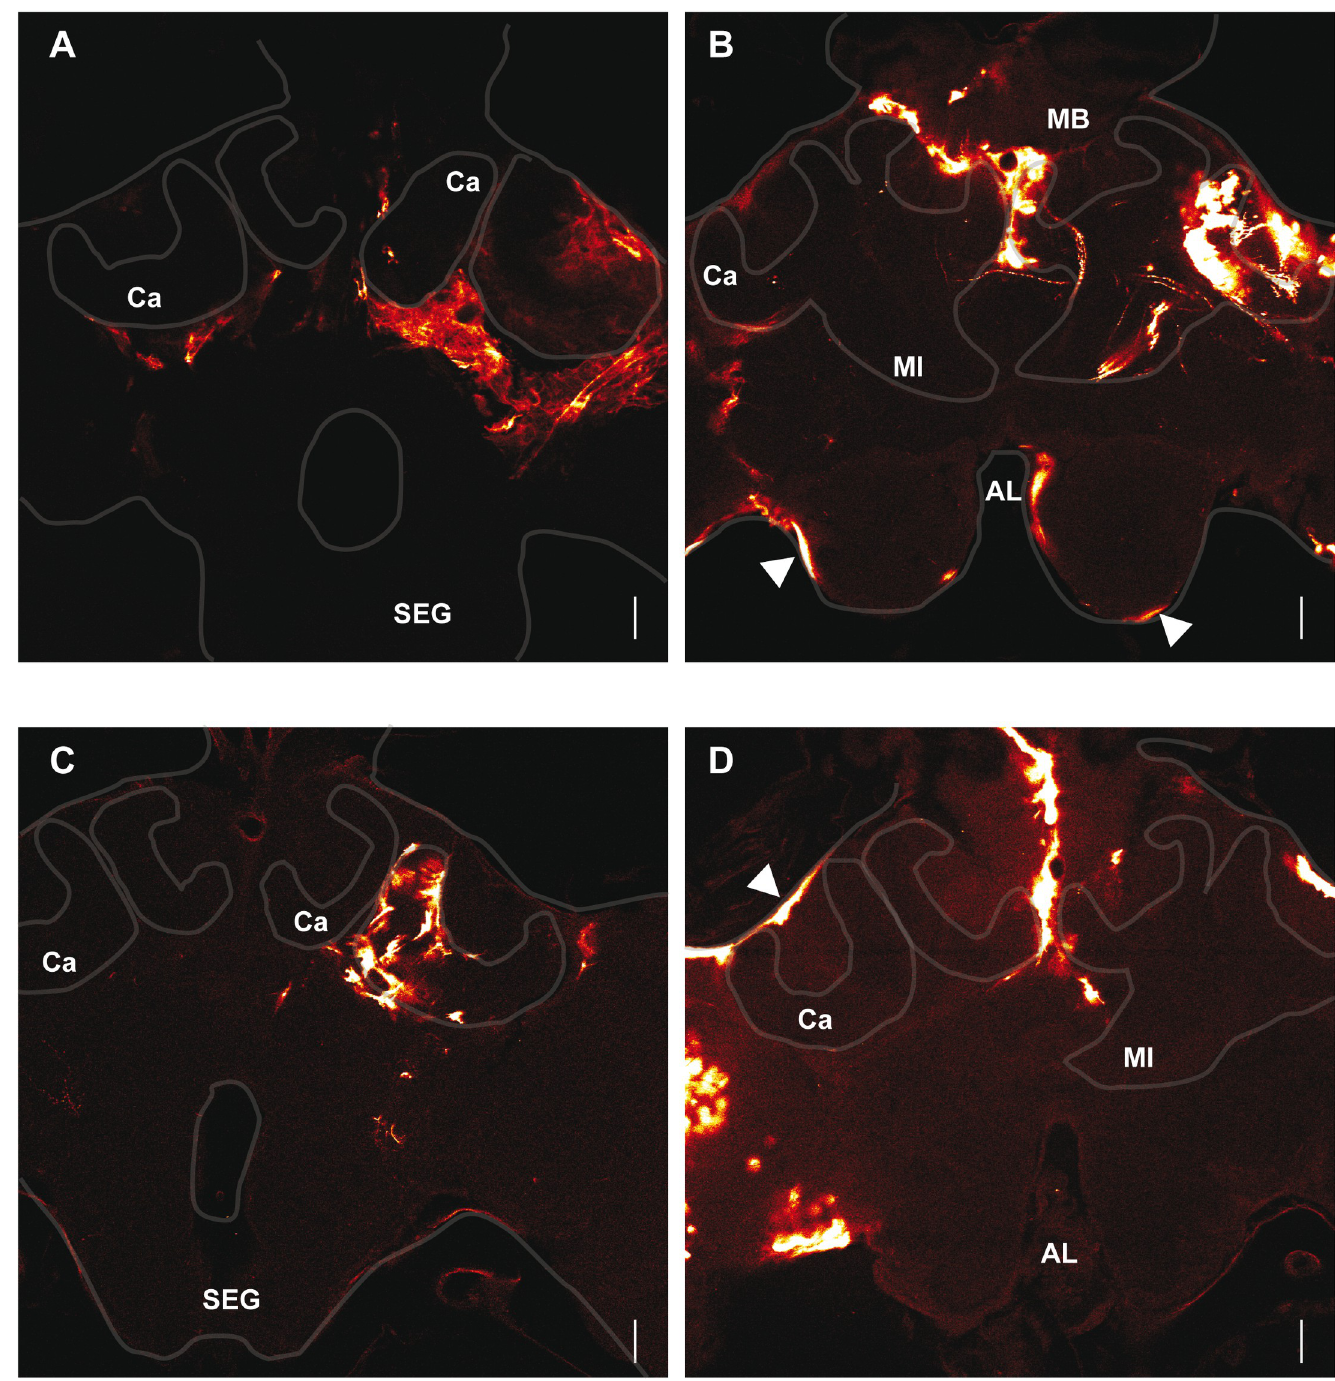
Fig 2. Distribution of anti-eGFP signals 3 days after different electroporation protocols. A: The animals were injected through the median ocellus and electroporated with the large wire electrodes. 100 V, 5X 25 ms. B: The animals were injected through the median ocellus and electroporated with the plate electrodes. The white arrowheads indicate perineural surface glia cells. 100 V, 5X 50 ms. C: The animals were injected into the MB calyx and electroporated with the plate electrodes. 100 V, 5X 25 ms. D: The animals were injected through the ocellus and electroporated with the small wire electrodes. The white arrowheads indicate subperineural surface glia cells. 100 V, 5X 25 ms. AL: Antennal lobe, SEG : Suboesophageal ganglion, Ca : Calyx, Ml : Medial lobe. Section Z-axis 1 μ M, Scale bar: 100 μ m.